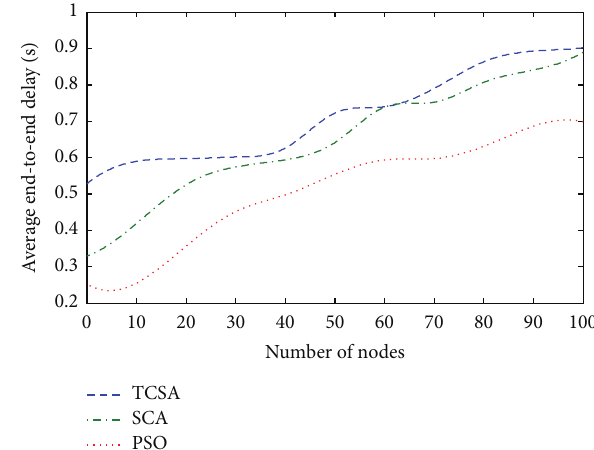
Figure 2: Plot between packet delivery ratio and network size.